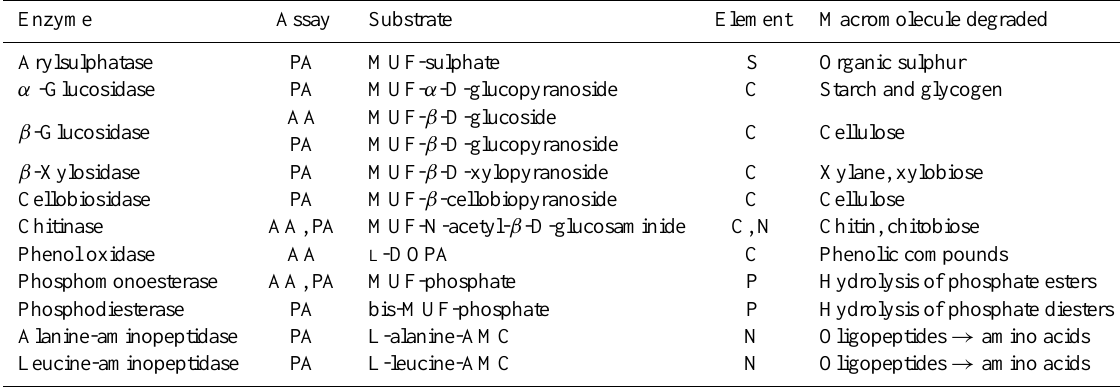
Table 2. Fluorogenic substrates used for the enzyme activity measurements. Enzyme Assay Substrate Element Macromolecule degraded Arylsulphatase PA MUF-sulphate S Organic sulphur MUF- α -D-glucopyranoside Starch and